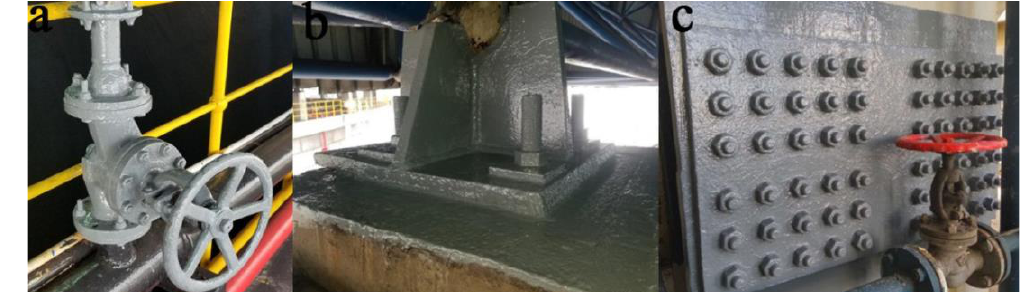
Figure 9. Protective effect of the modified nanoscale titania coating after 3 years: ( a ) pipeline valve, ( b ) dome support of coal yard, ( c ) boiler connecting bolt.